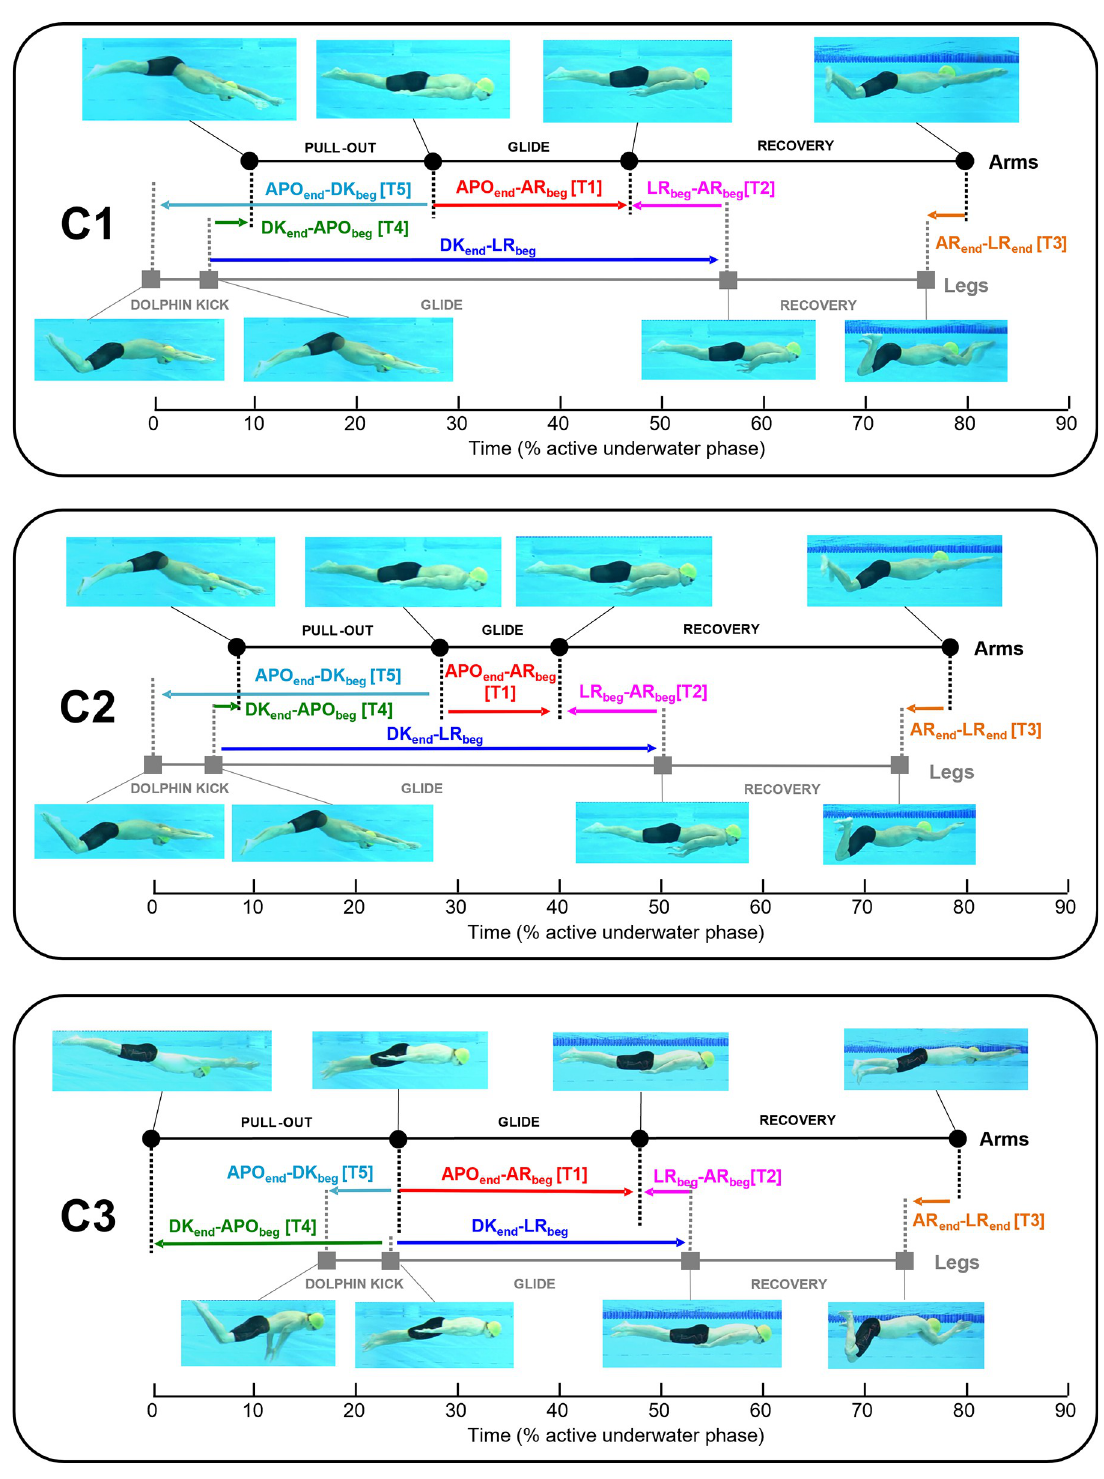
Fig 3. Diagram of the relative duration of dolphin kick, arm pull-out and recovery motion as well as each time gap for each cluster. Right-pointing and left-pointing arrows show the positive and negative time gap, respectively.